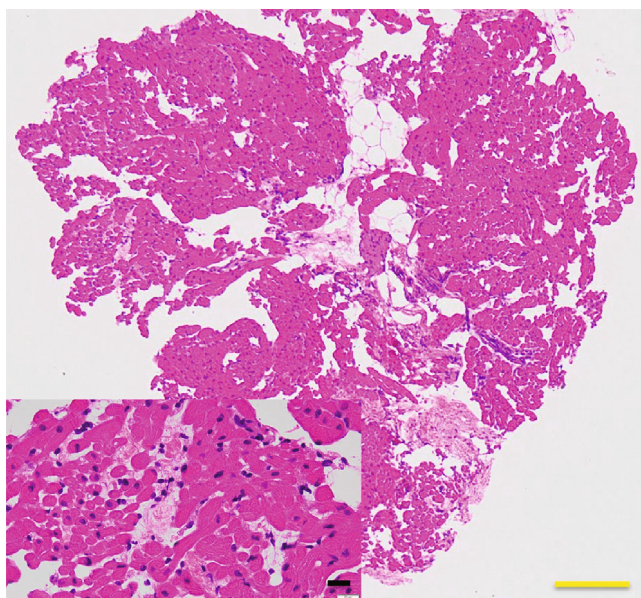
Figure 4: Histological images of biopsied myocardium. Yellow scale bar = 20 μ m ; black scale bar = 20 μ m